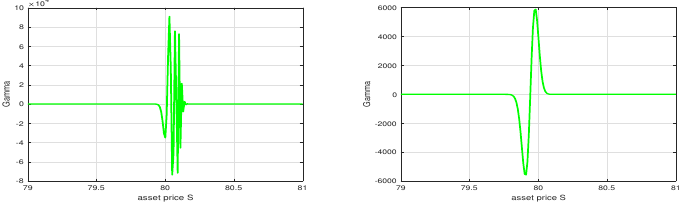
Figure 13. Plots of Gamma obtained with the MADE scheme ( left ) and the MMADE scheme ( right ), with parameter values r = 0.07, σ = 0.001, a = − 8800, K = 50, T = 0.01, U = 80, L = 20, S max = 120, ∆ S = 0.01 and ∆ t = 10 − 4